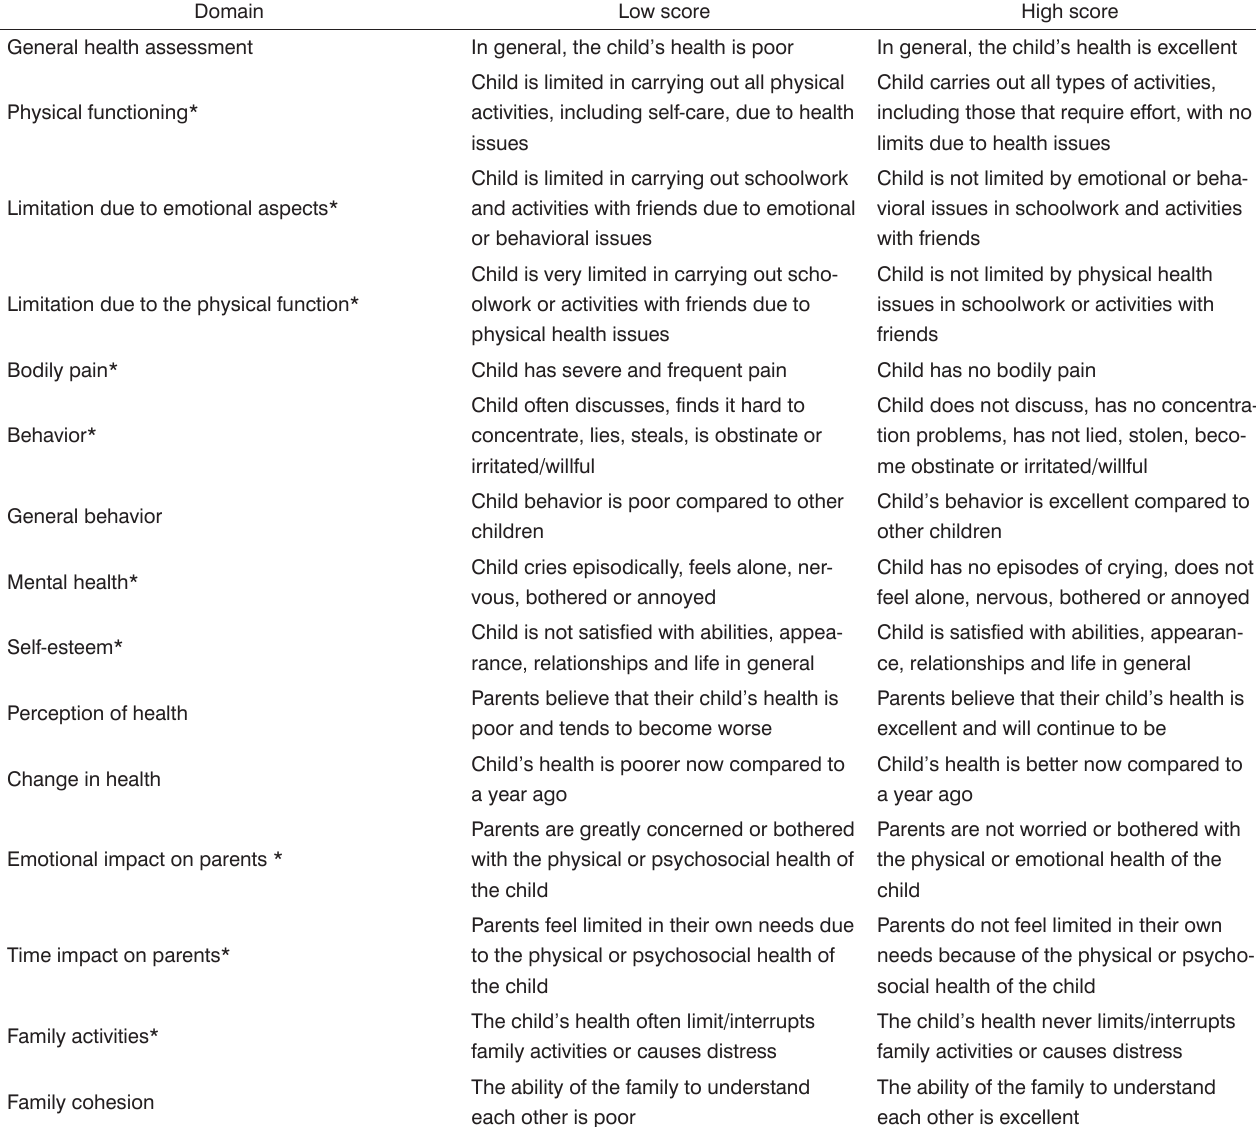
Table 1. Interpretation of domain scores of the CHQ PF-50